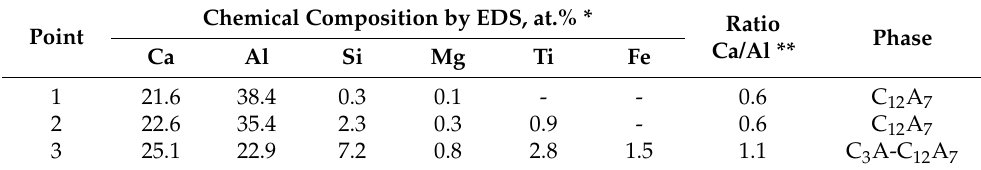
Table 4. EDS analysis of micro-areas indicated in Figure 5. Chemical Composition by EDS, at.% * Point